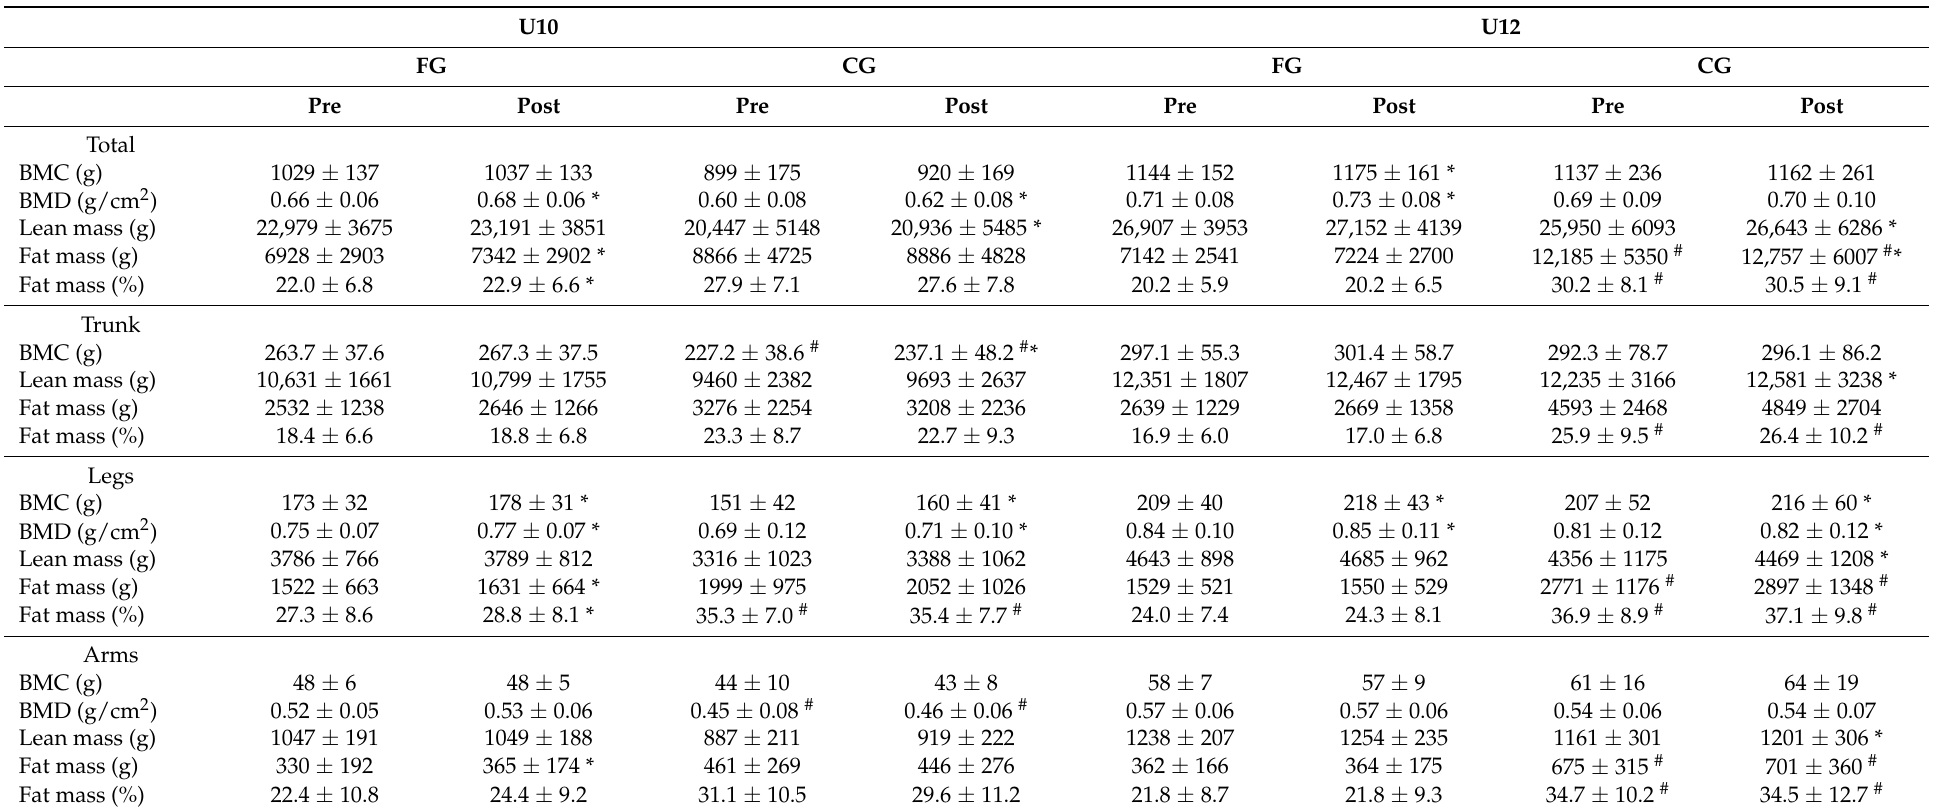
Table 1. Body composition before (pre) and after (post) a 12-week intervention with two days of training football plus one match per week in young U10 and U12 players (FG) and without football training in young controls